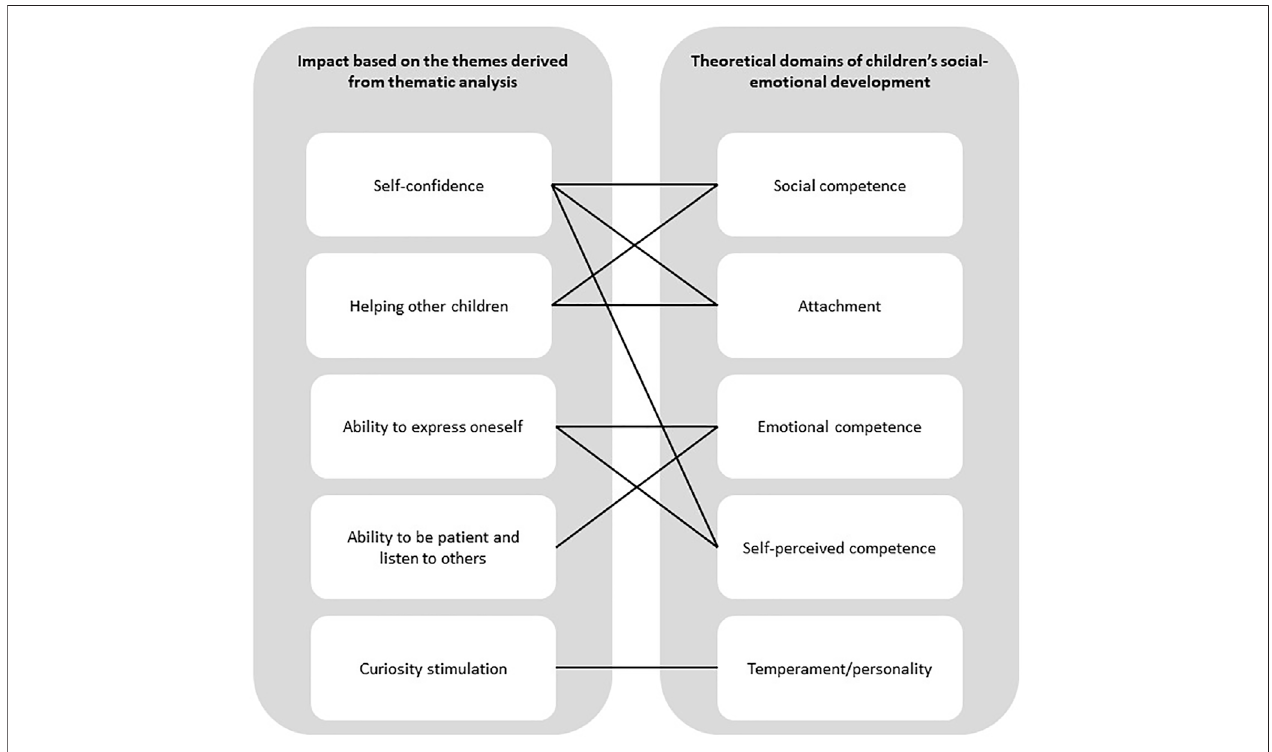
FIGURE 1 | Overview of themes based on the interviews and the linked theoretical constructs of social-emotional development, based on the literature.